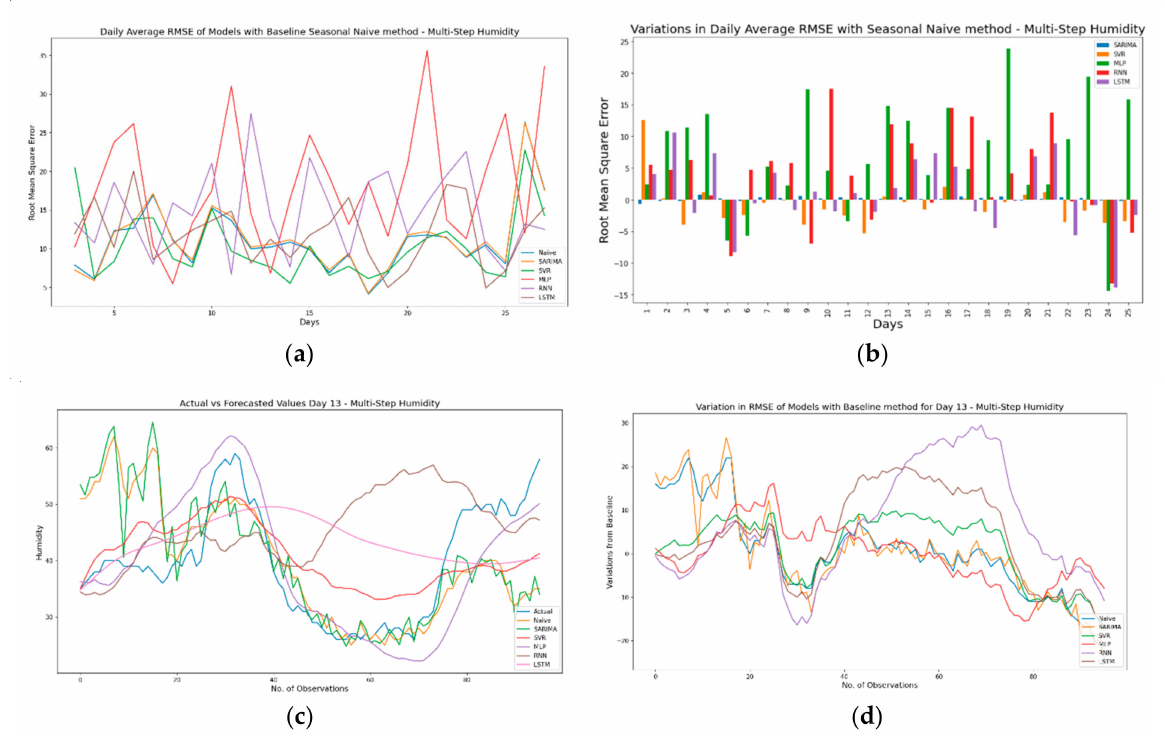
Figure 16. Comparative visualization for model performance against a baseline model—Multi-step ahead Humidity ( a ) daily average RMSE of different models with baseline seasonal naïve model ( b ) variations in daily average RMSE with performance against seasonal naïve model ( c ) combined Actual vs. Forecasts generated by different TSFAs for Day 13 ( d ) variations in RMSE of models against seasonal naïve model for Day